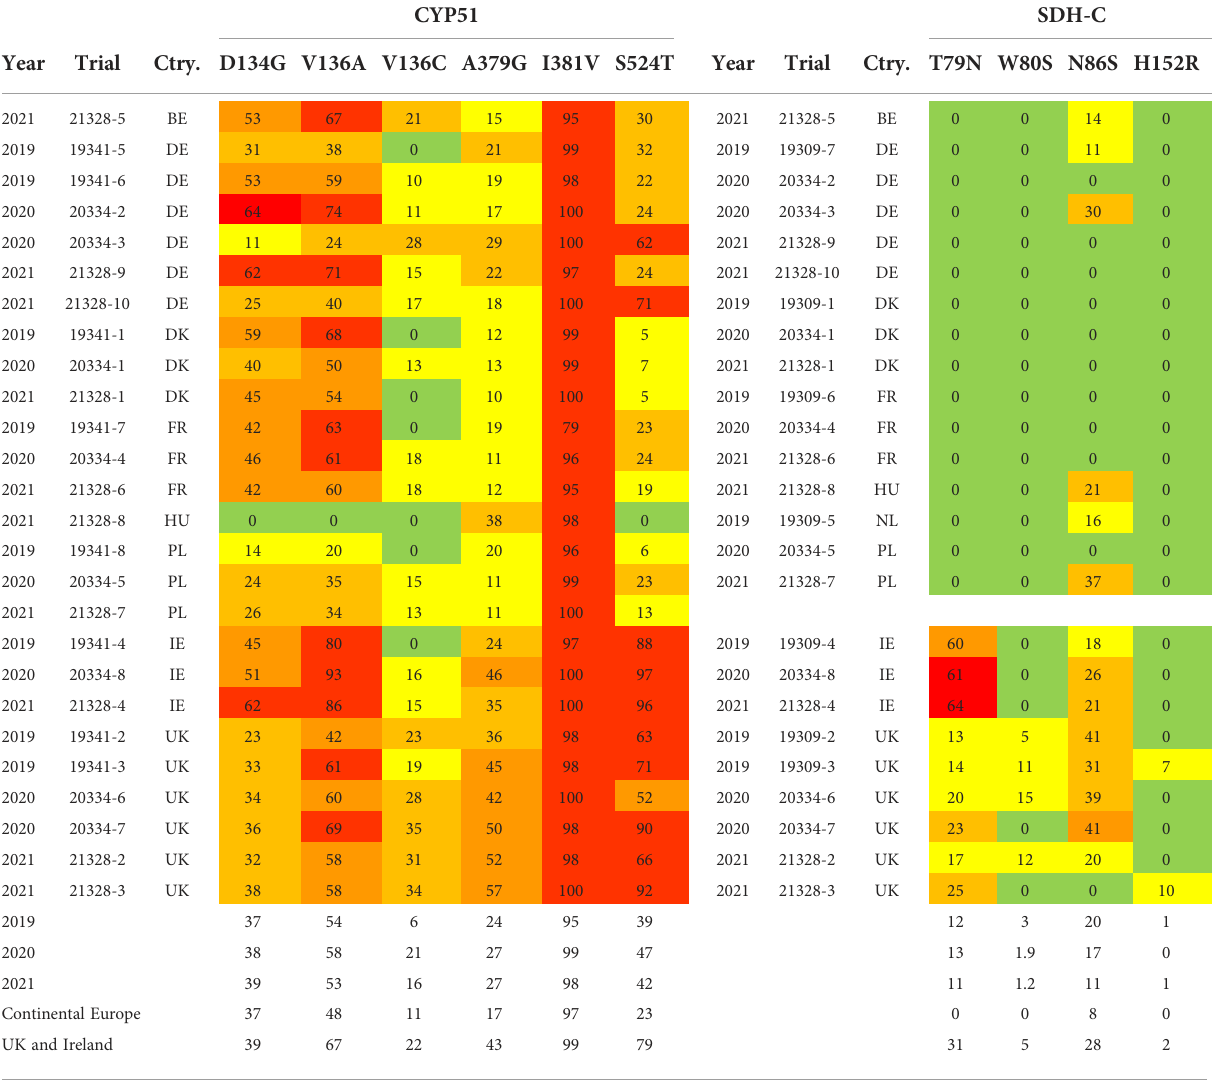
TABLE 6 Frequencies of sdh-c and